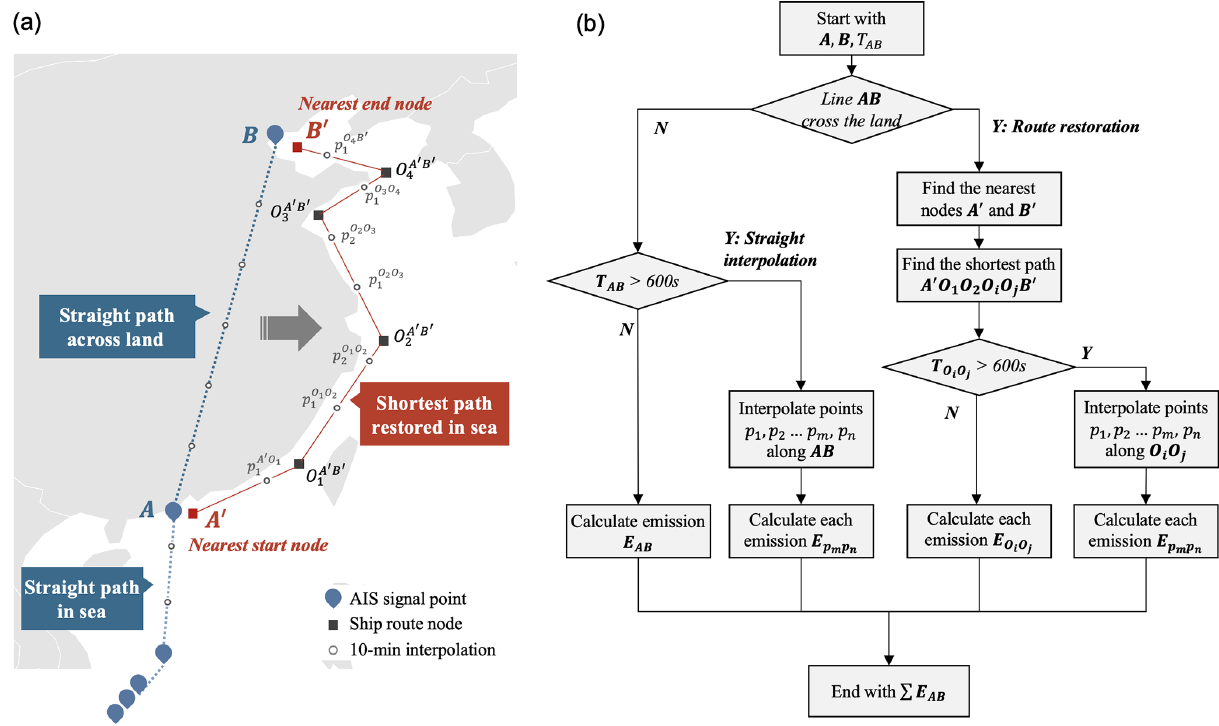
Figure 4. Diagrammatic sketch of the ship route restoration algorithm. (a) Sketch map of the route restoration algorithm with an example of route AB . (b) Algorithm flow chart of the example of route AB